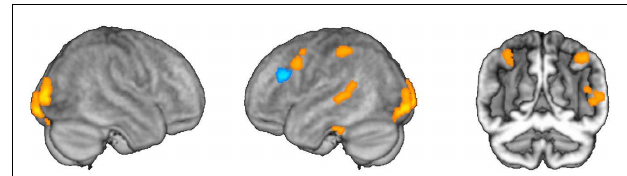
FIGURE 3 | Selective effects of activation and adaptation. Regions depicted in orange showed main effects of grammatical category in event-related activation. Regions depicted in blue showed main effects corresponding to adaptation for category-specific